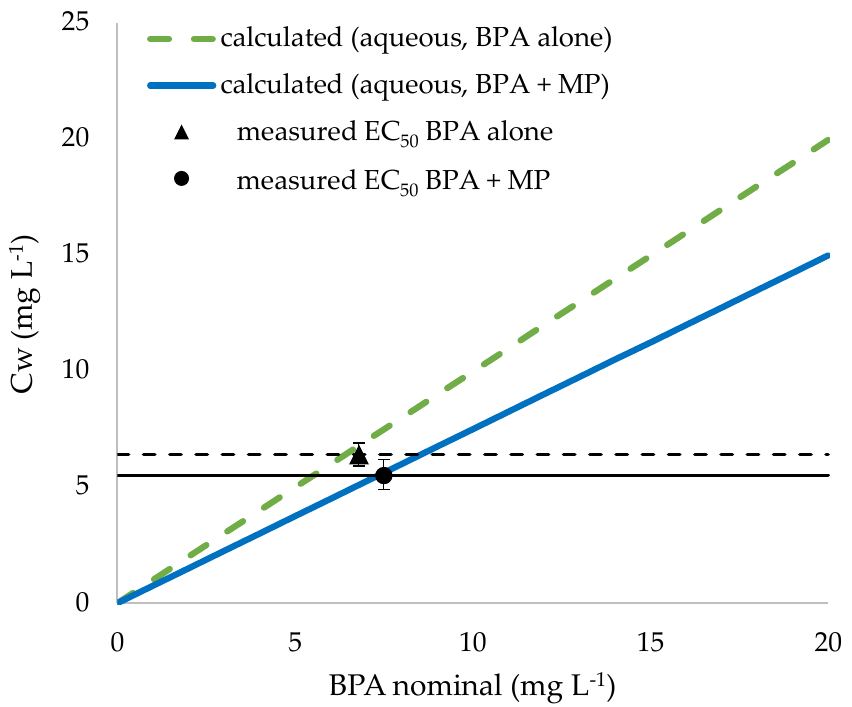
Figure 3. Calculated concentrations of bisphenol A (BPA) in water for BPA alone and BPA in combination with microplastics (MP) (treatment BPA + MP) represented as colored lines, together with EC 50 values based on measured concentrations of BPA in water and corresponding EC 50 lines.